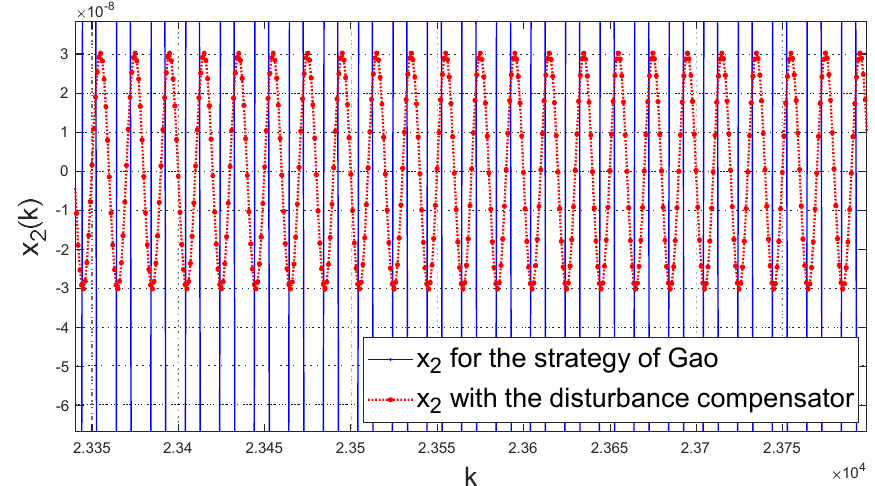
Figure 11. x 2 ( k ) for both control strategies in the sliding phase (zoomed).